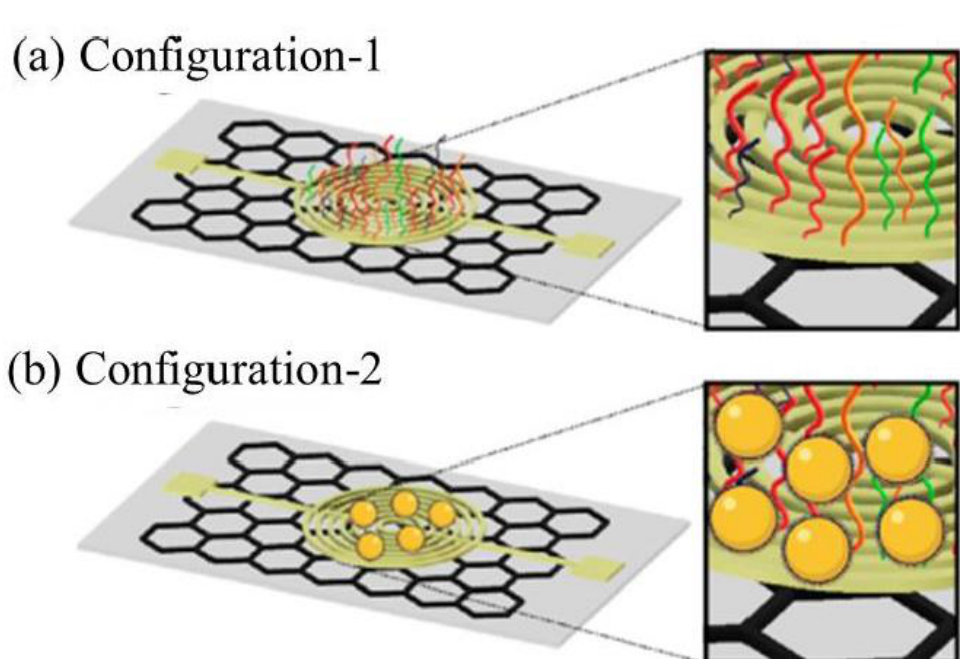
Figure 8. The types of configurations, which involved the ( a ) direct conjugation of probes to the gold electrode surface and ( b ) the probes were conjugated to the AuNPs and then deposited at the sensor platform. Reproduced from Alafeef et al. [120].